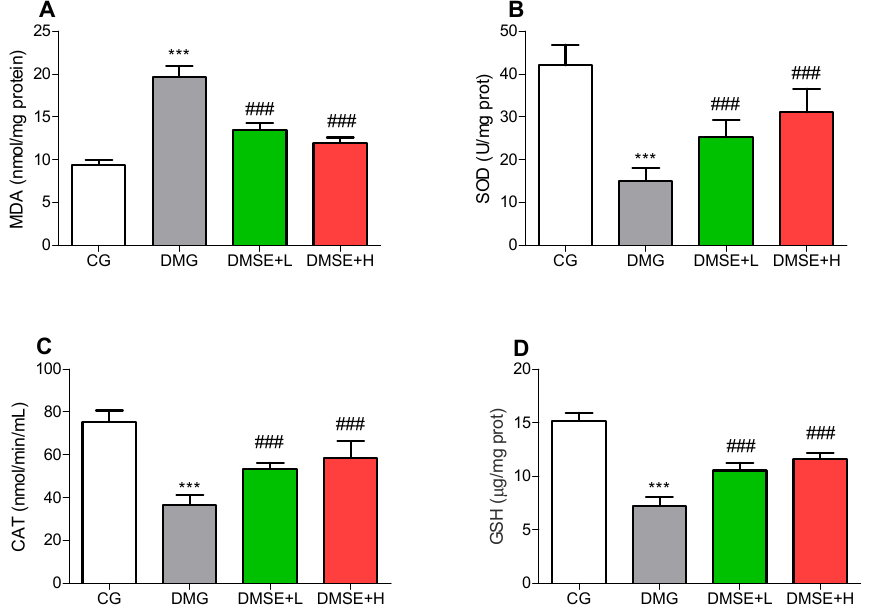
Figure 4. Effect of MSE on oxidative stress parameters in the brain of diabetic rats ( A ) MDA, ( B ) SOD,